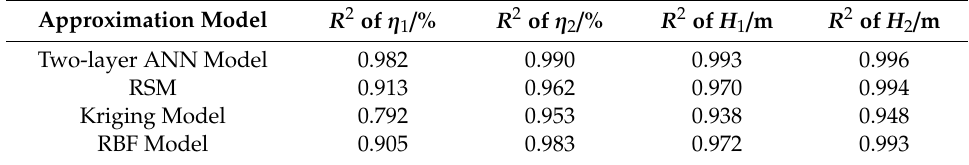
Table 7. The accuracy of optimization objective predicted by different approximation models. Approximation